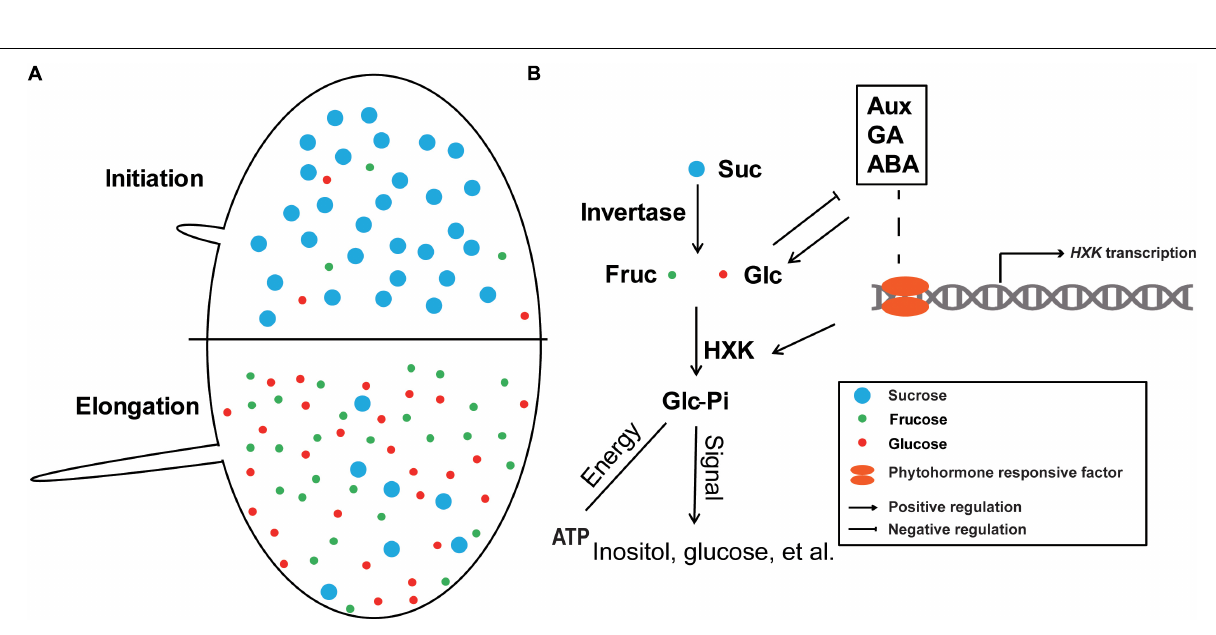
Frontiers in Plant Science |